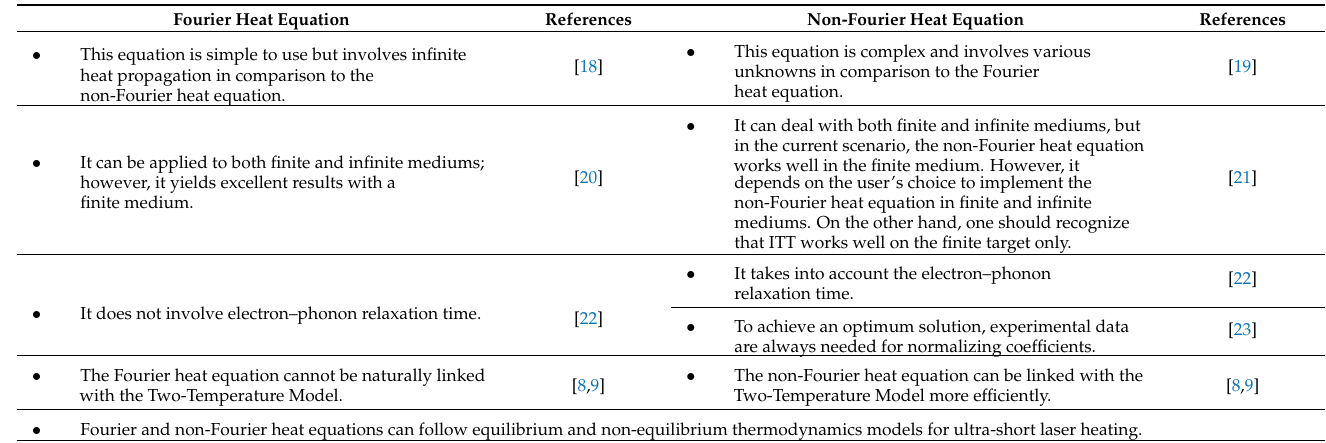
Table 1. Comparison between Fourier and non-Fourier heat